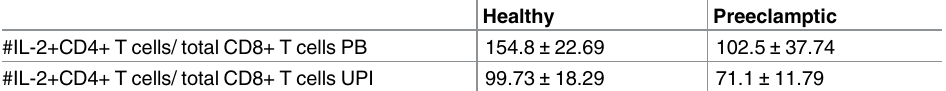
Table 7. # +/- SEM IL-2+ CD4+ T cells/ total CD8+ T cells in PB and at the UPI of healthy and preeclamp- tic (PE) patients, see also Fig 1G.